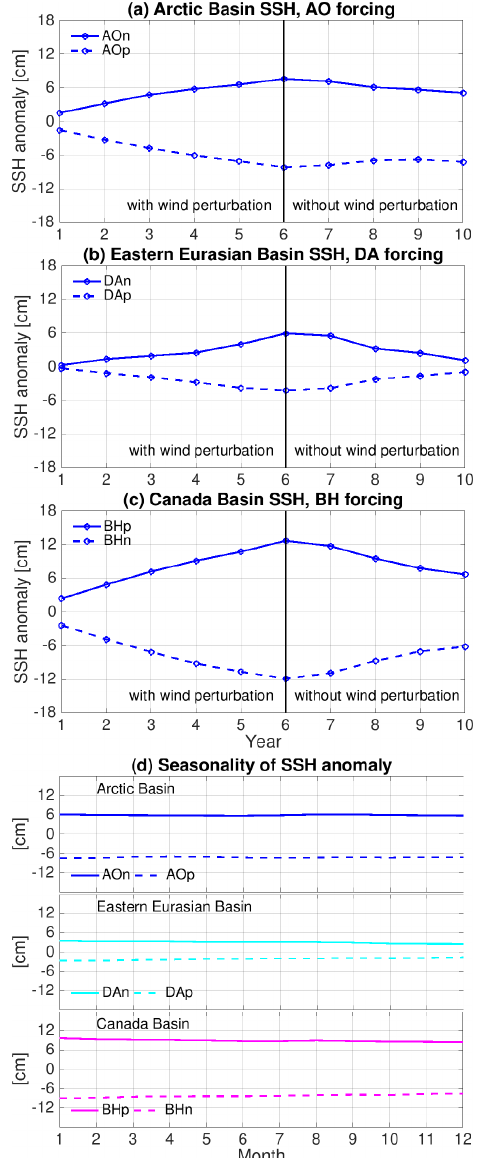
Figure 5. (a) Anomaly of annual mean sea surface height (SSH, cm) averaged in the Arctic Basin (the area where bottom bathymetry is deeper than 500m) in the simulations with Arctic Oscillation (AO) perturbations. The anomalies are referenced to the control run. (b) The same as (a) , but for the mean in the eastern Eurasian Basin (indicated by blue lines in Fig. 4c) in the simulations with Dipole Anomaly (DA) perturbations. (c) The same as (a) , but for the mean in the Canada Basin (indicated by blue lines in Fig. 4e) in the sim- ulations with Beaufort High (BH) perturbations. (d) The mean sea- sonal cycle of the SSH anomaly (the difference between the sensi- tivity runs and the control run) in the last 4 years, which indicates that the seasonal variation in the SSH anomaly is negligible. Note that the SSH in each individual simulation does have clear seasonal variability (not